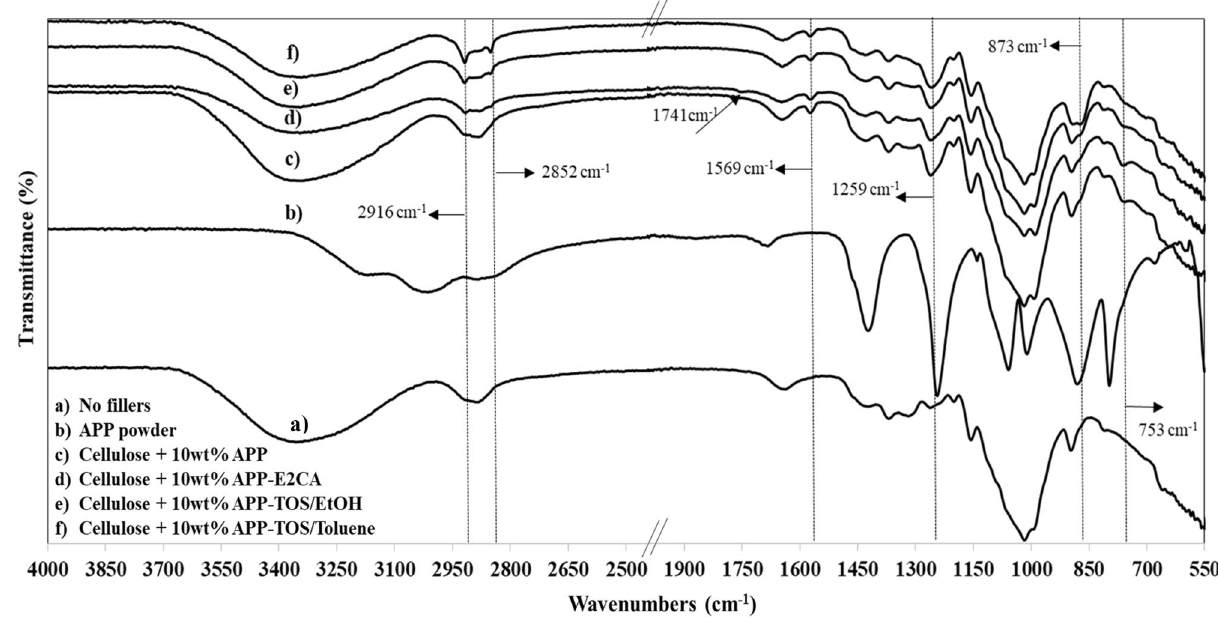
Figure 4. ATR-FTIR of ( a ) cellulose with no flame-retardants, ( b ) APP powder, ( c ) cellulose-APP composite, ( d ) cellulose-APP composite—E2CA coated, ( e ) cellulose-APP composite—TOS/EtOH coated and ( f ) cellulose- APP composite—TOS/Toluene coated.